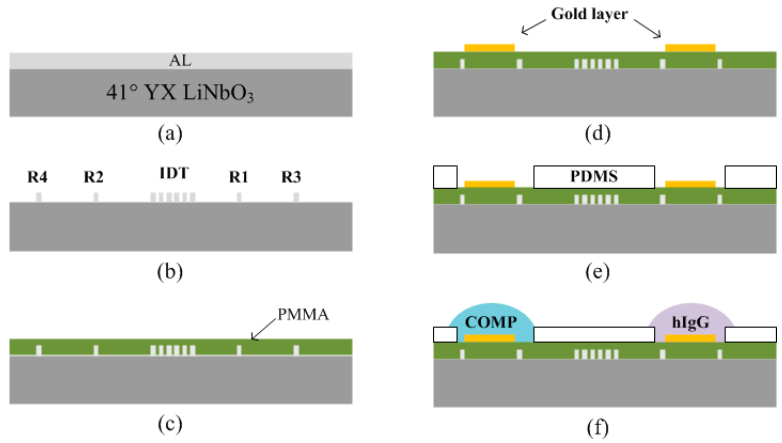
Figure 4. Fabrication procedures. ( a ) Al deposition; ( b ) wet etching of aluminum to complete one port delay line; ( c ) PMMA overlayer (waveguide) spin coating; ( d ) Au deposition and patterning; ( e ) PDMS slab bonding for opened hole; and ( f )